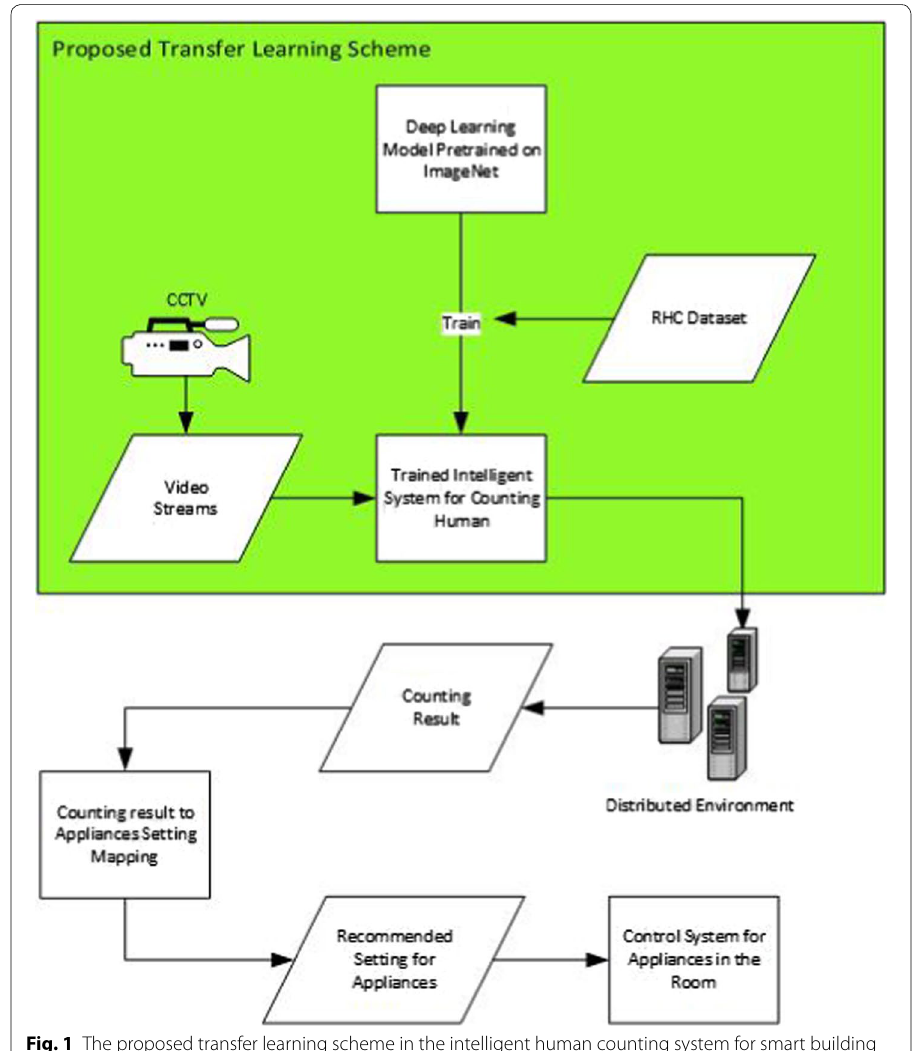
Fig. 1 The proposed transfer learning scheme in the intelligent human counting system for smart building